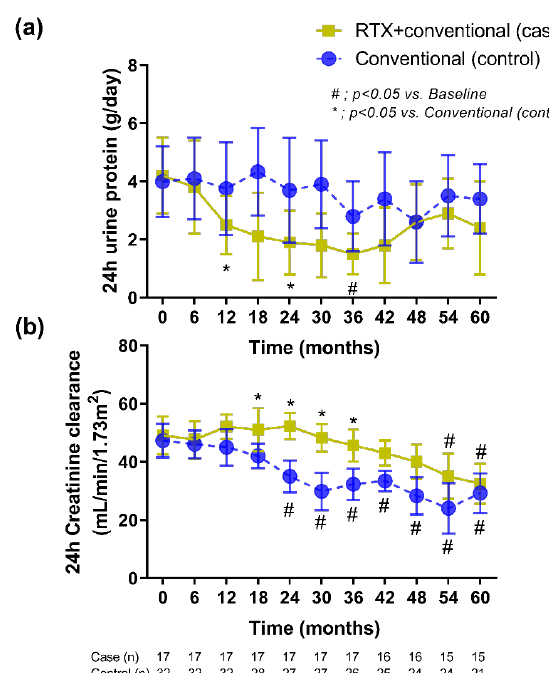
Figure 2. The treatment responses in the kidney transplant recipients with rituximab administration plus the conventional standard treatment versus those with the conventional standard treatment alone as demonstrated by ( a ) 24 h proteinuria and ( b ) 24 h creatinine clearance. The data included only recipients who had a follow-up duration ≥ 36 months with censoring in whom there was nonfunctioning graft (or required long-term renal replacement therapy). RTX, rituximab.